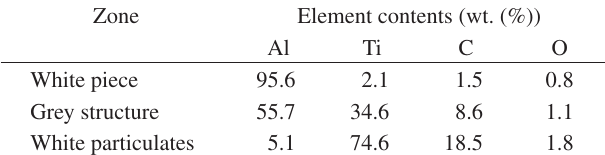
Table 1. Element contents analysis in different zone of Al-Ti-C sintered blocks.